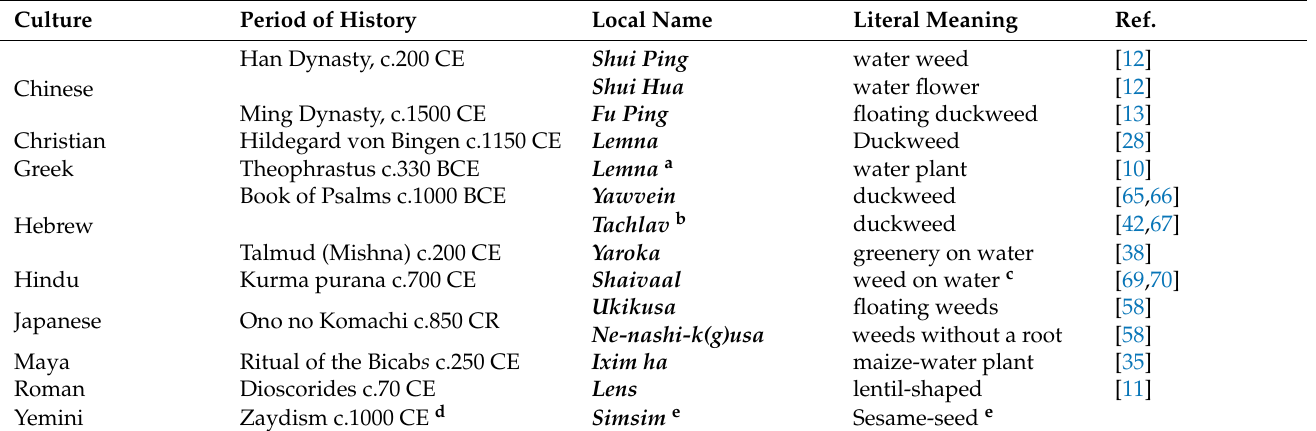
Table 5. Local names of duckweed in ancient cultures.